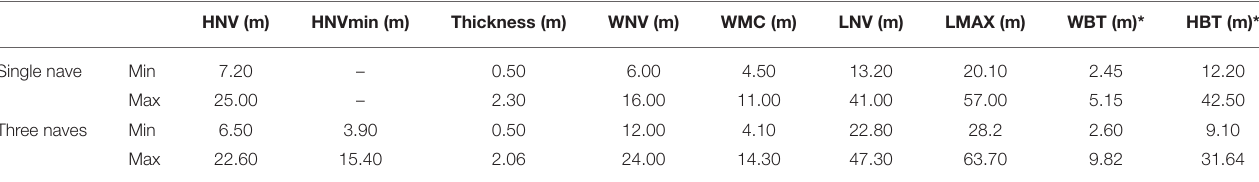
TABLE 1 | Range of parameters for the model of single nave and three naves.